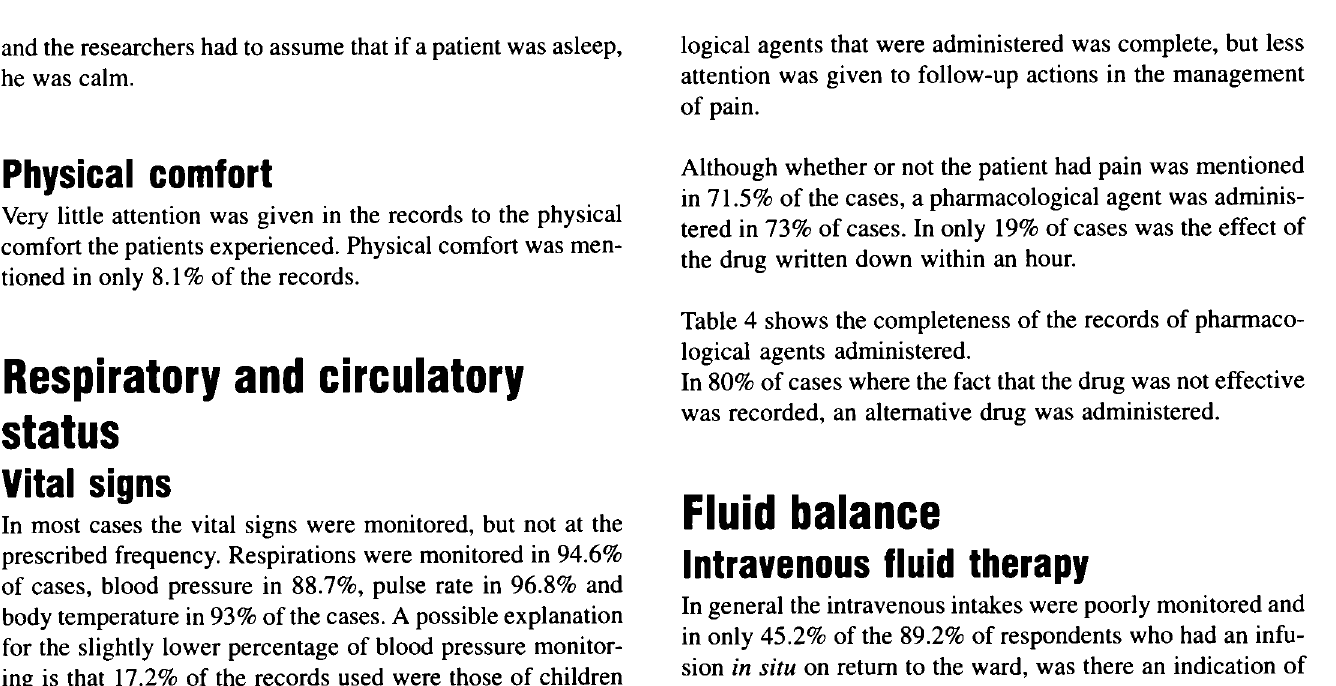
Table 2: Frequency of monitoring of vital signs as measured against the prescribed guidelines for